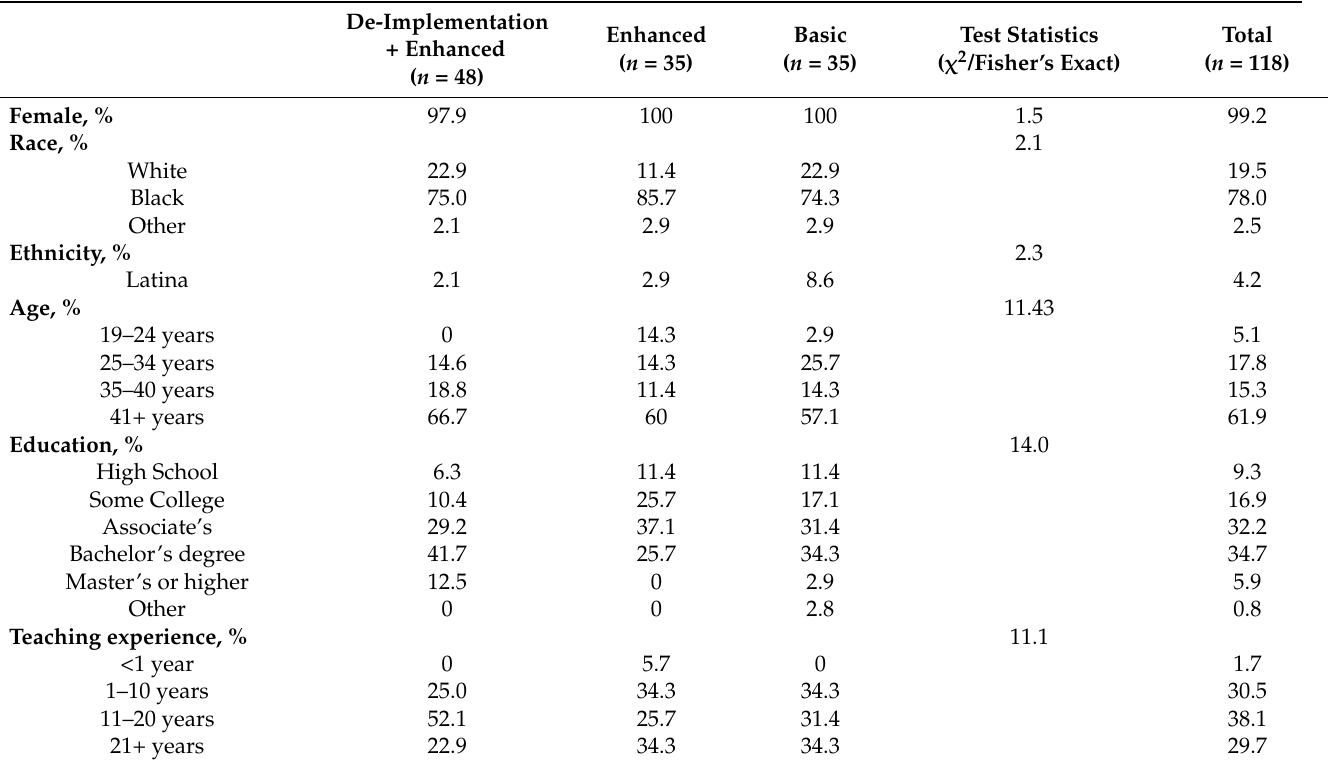
Table 2. Teacher demographic